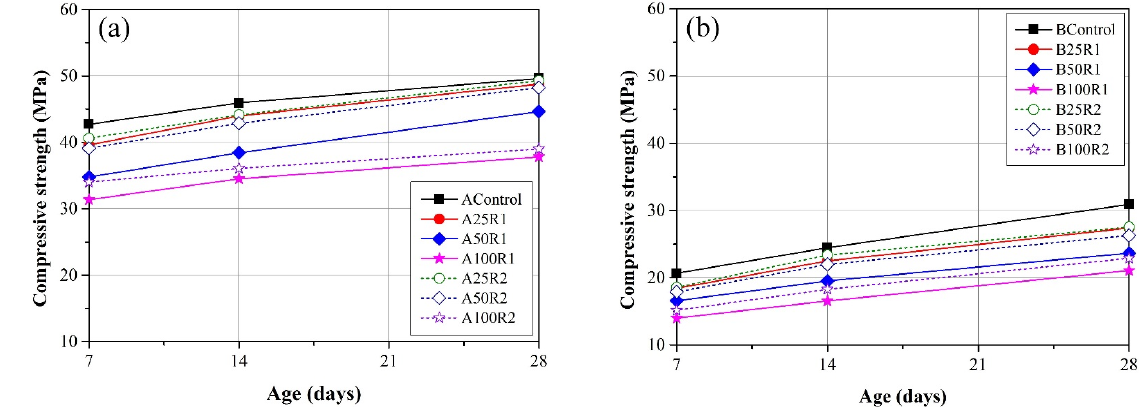
Figure 9. Development of compressive strength in mortars with ( a ) W/C = 0.35, and ( b ) W/C = 0.55.